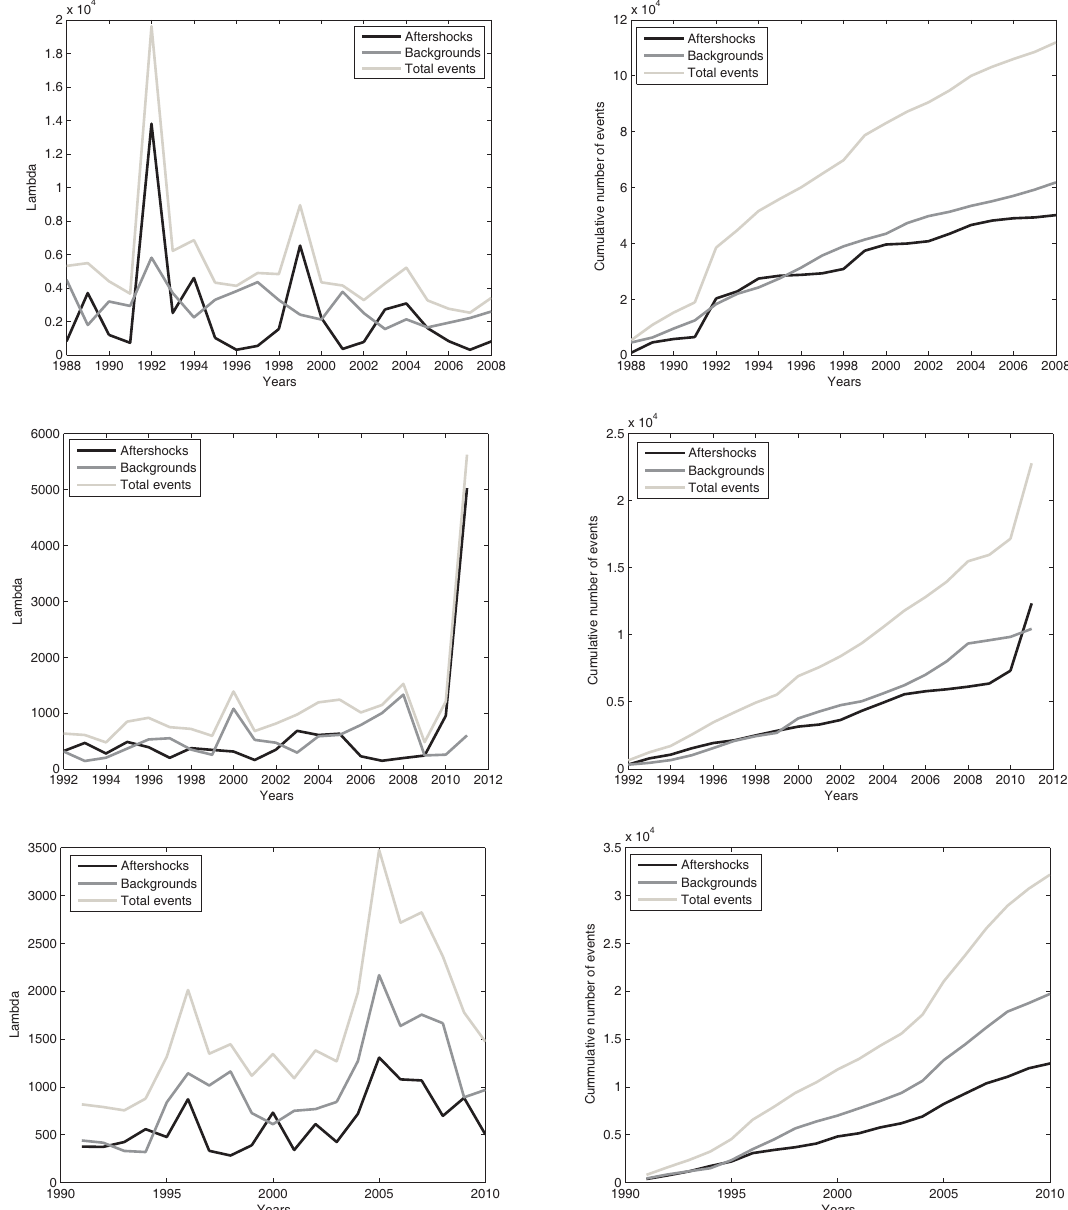
Fig. 11. Plot of lambda values and cumulative number of events characterized as aftershocks and background using the proposed tri-stage cluster identification model: (top left-right) lambda and cumulative plot for California catalog, respectively; (middle left-right) lambda and cumulative plot for Japan catalog, respectively; (bottom left-right) lambda and cumulative plot for Indonesian catalog, respectively.